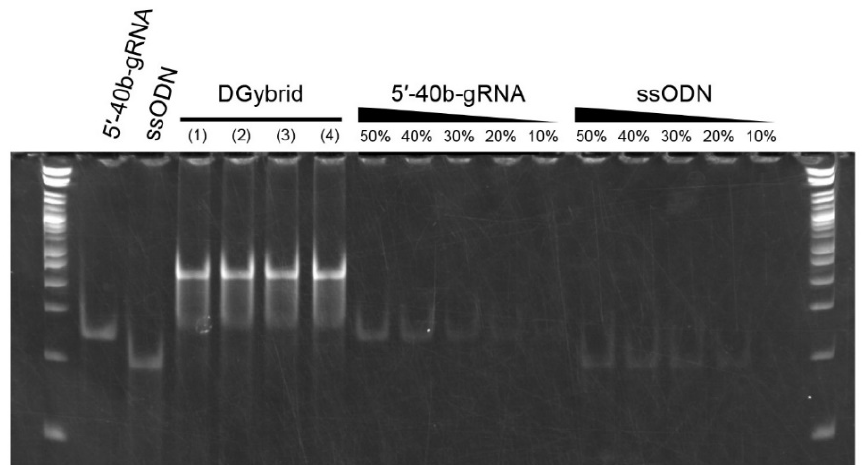
Figure 2. Native-PAGE analysis to confirm DGybrid formation. Values above the lanes of 5 ′ -40b-gRNA and ssODN indicate the relative molar amounts of the applied sample. In the two lanes at both ends, 1 kb Plus DNA Ladder was applied. The DGybrid samples were prepared in four different conditions: (1) TE buffer, (2) TE buffer + 10 mM NaCl, (3) TE buffer + 100 mM NaCl, and (4) ethanol precipitation of the sample prepared in condition